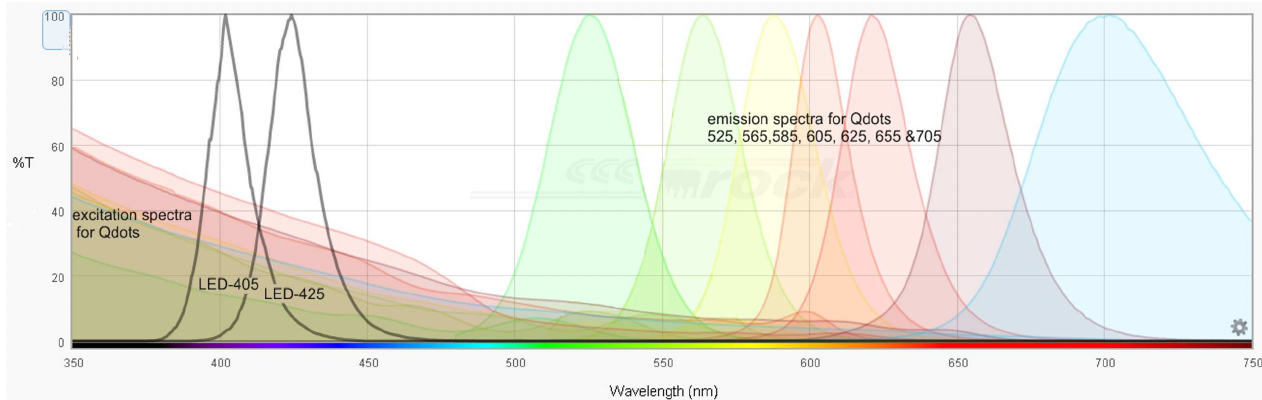
Fig 4. Excitation & emission spectrafor Qdotfluorescence. The graphs show the theoretical excitation spectra and emissionspectra for the Qdot fluorophores used in the study—adapted fromSemrockSearchlight.com.Note that at shorterwave lengthsthe excitation shouldbe better. The excitation filterused is allowing wave lengthsfrom350 to 460 with a slightlybettertransmission rate around405 than 425 (ASCIIdata in [15]); the dichroicmirroris 475nmand the emissionfilteris a 500nm long pass (Chromafilterset 32013).The illumination spectra for LED-405& LED- 425nmare shown in